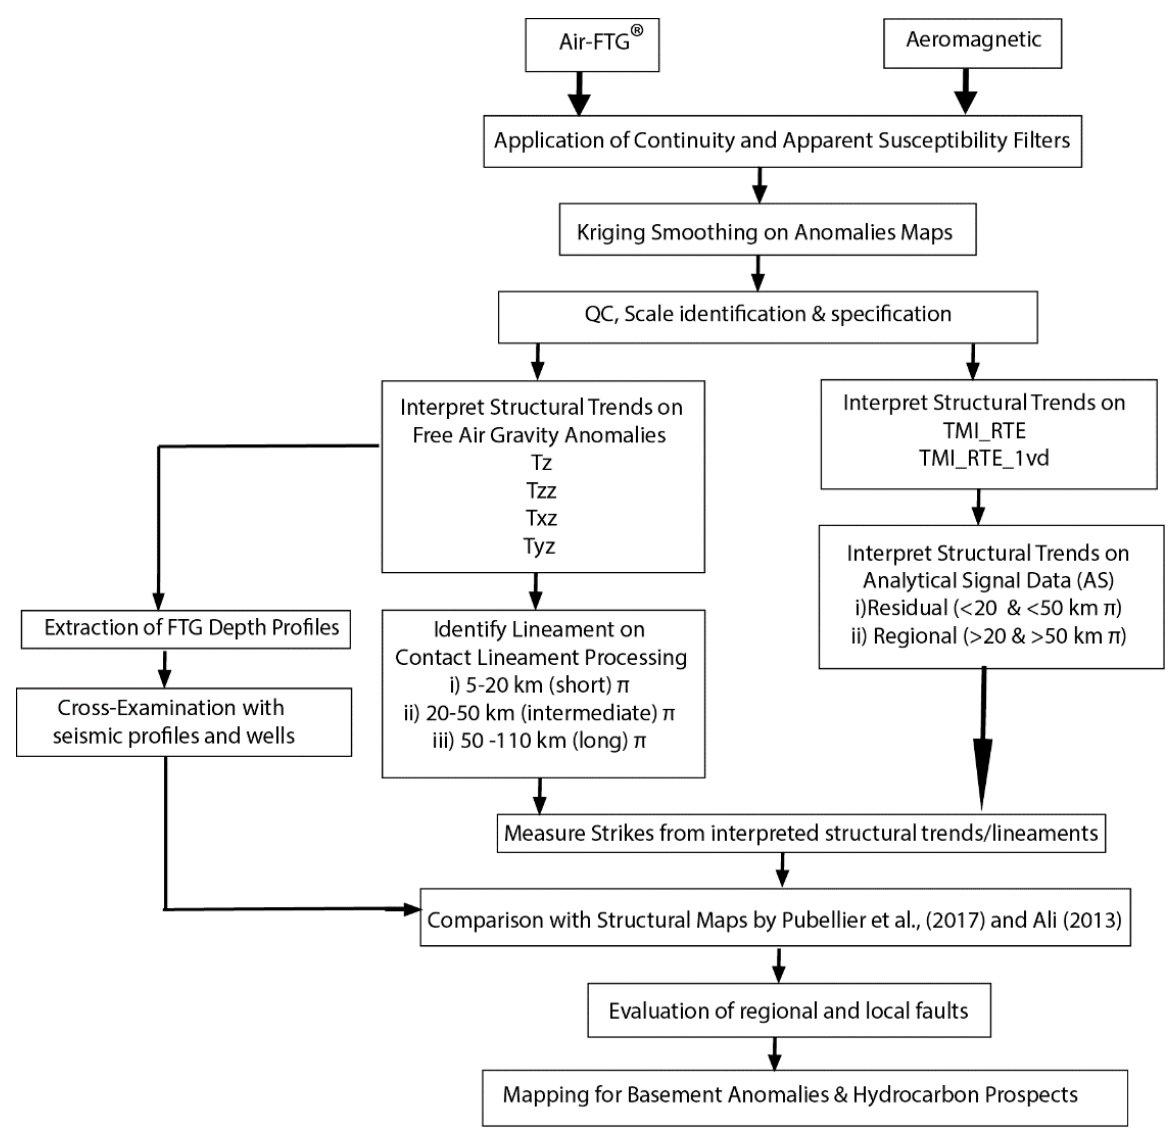
Figure 4. Summary of interpretation workflow for airborne gravity and aeromagnetic data utilized in this study.